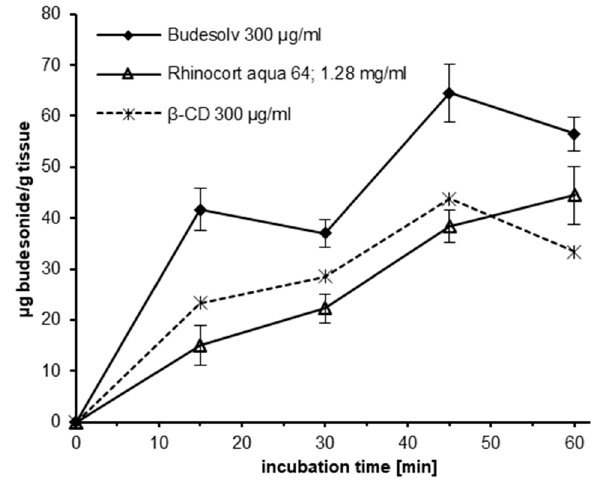
Figure 2. Permeation of budesonide into porcine nasal mucosa. Budesonide tissue concentrations ( µ g / g tissue as measured by HPLC-MS / MS, y -axis) in porcine nasal mucosa treated with either Budesolv or β -CD complex containing 300 µ g / mL budesonide or Rhinocort ® aqua 64 containing 1.28 mg / mL budesonide, were evaluated after di ff erent incubation time points ( x -axis). Data are expressed as mean ± standard deviations (SD) ( n = 3). Table 1. Results of the statistical analysis of the permeation of budesonide into porcine nasal mucosa after incubation with different formulations .